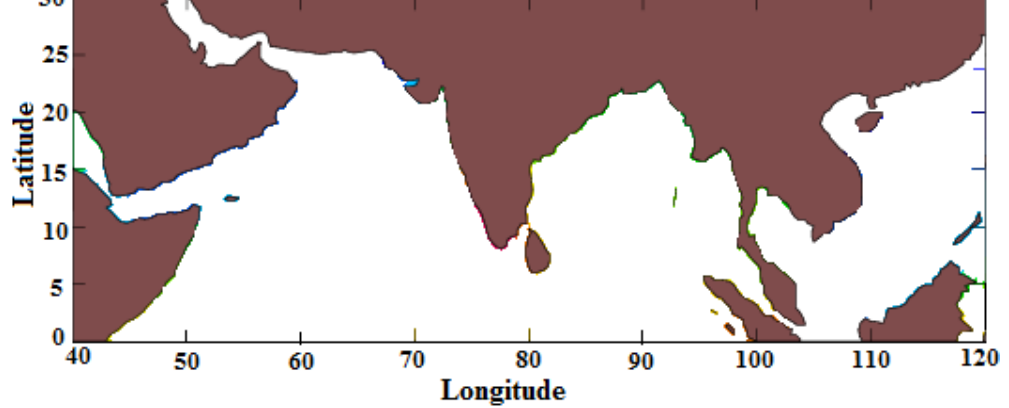
Figure 1. Map showing the study region.